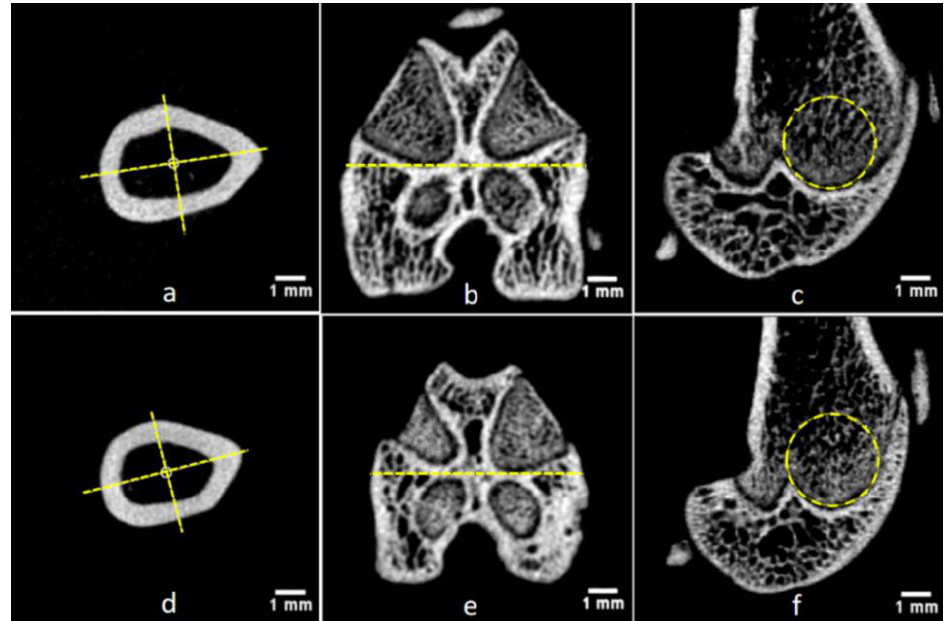
Figure 9. Comparison of bone size between male and female rats. Geometric parameters in the male